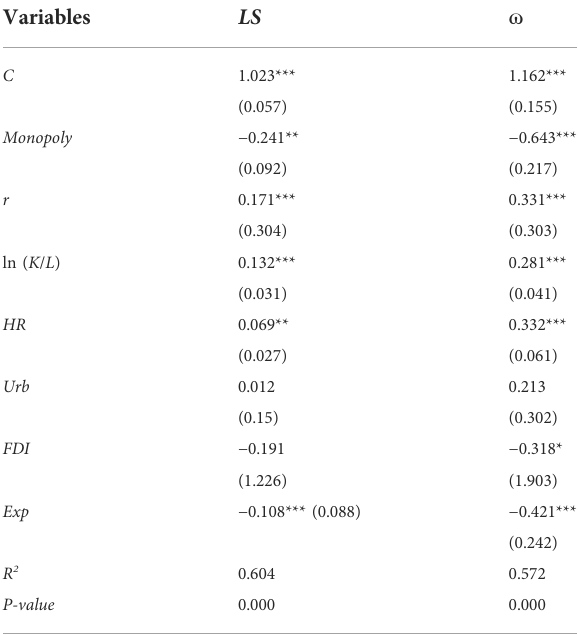
TABLE 7 The impact of monopolies in the fi nancial sector on labor income in Shanghai. Variables